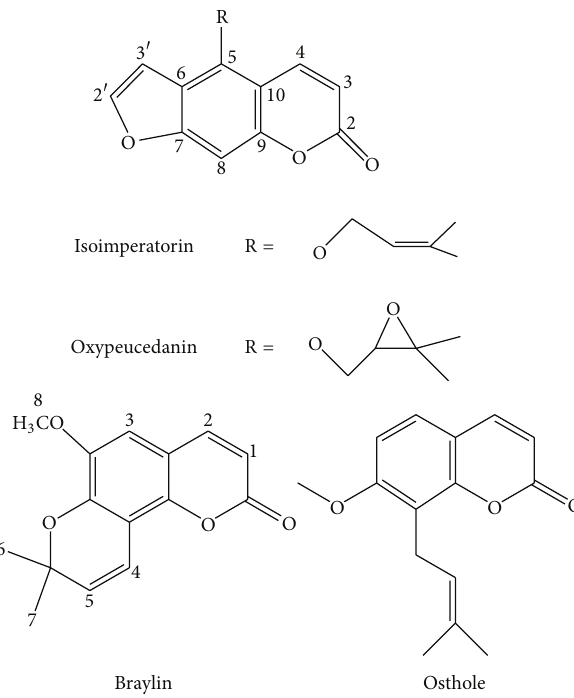
Figure 1: Chemical structures of isolated